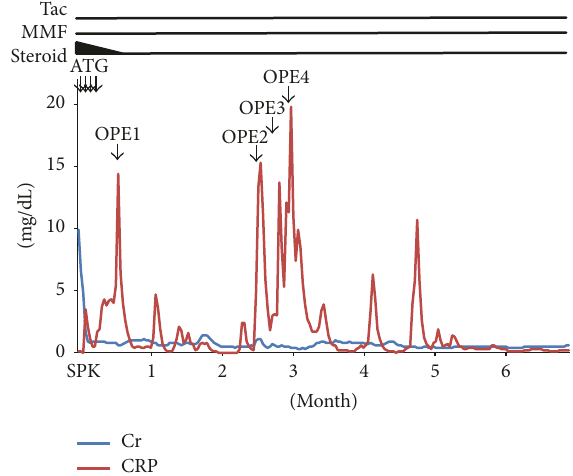
Figure 1: Postoperative course. The pancreas graft was salvaged by four laparotomies to repair duodenal perforation after pancreas- kidney transplantation.